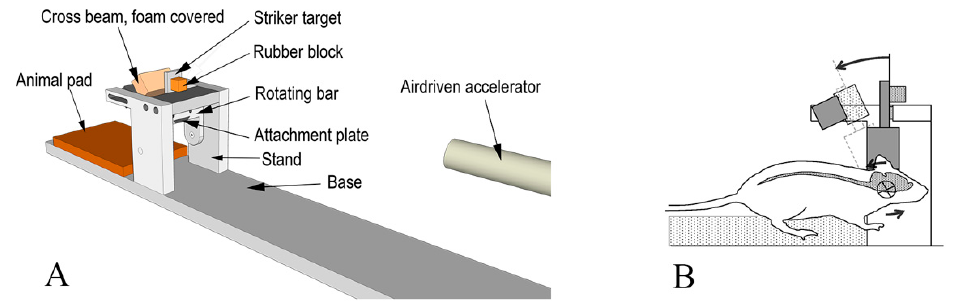
Figure 1. Experiment setup scheme. ( A ) Oblique view of the test device. ( B ) Side view of the test subject placed within the device. The central nervous system (CNS) is schematically depicted, and the center of rotation highlighted. The arrows indicate the direction of movement.